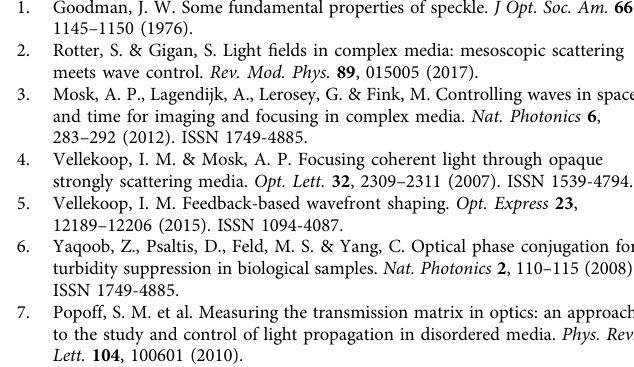
a narrower time interval. The intensity of N